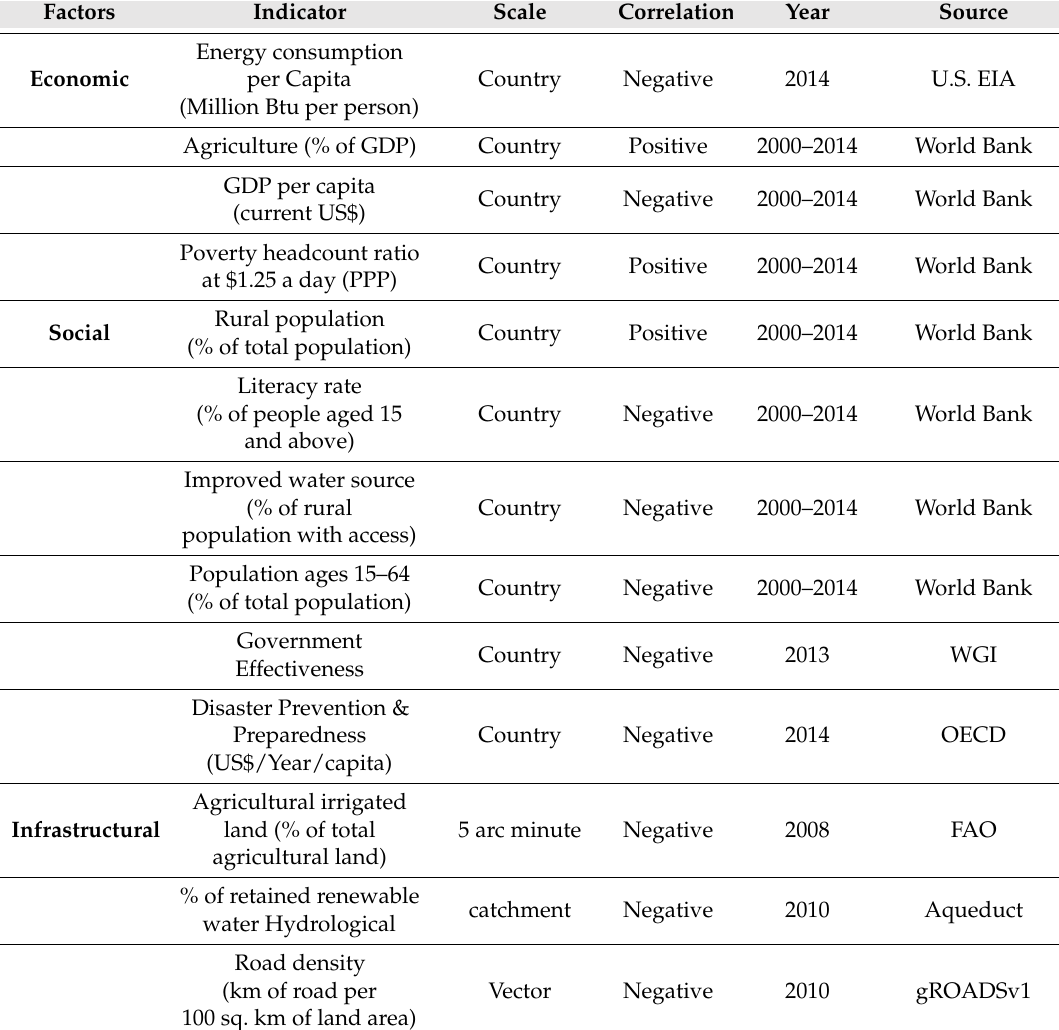
Table A3. Indicators of drought vulnerability in detail: corresponding factors, data sources, reference dates and correlation to the overall vulnerability (negatively correlated indicators are related to adaptive